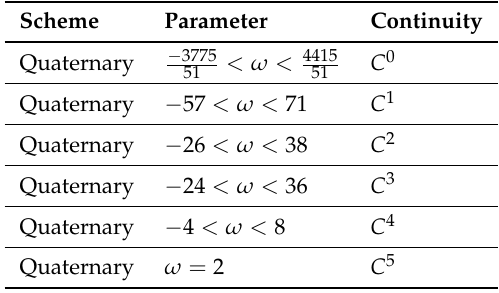
Table 6. Continuity order of Quaternary scheme (Equation (18)).